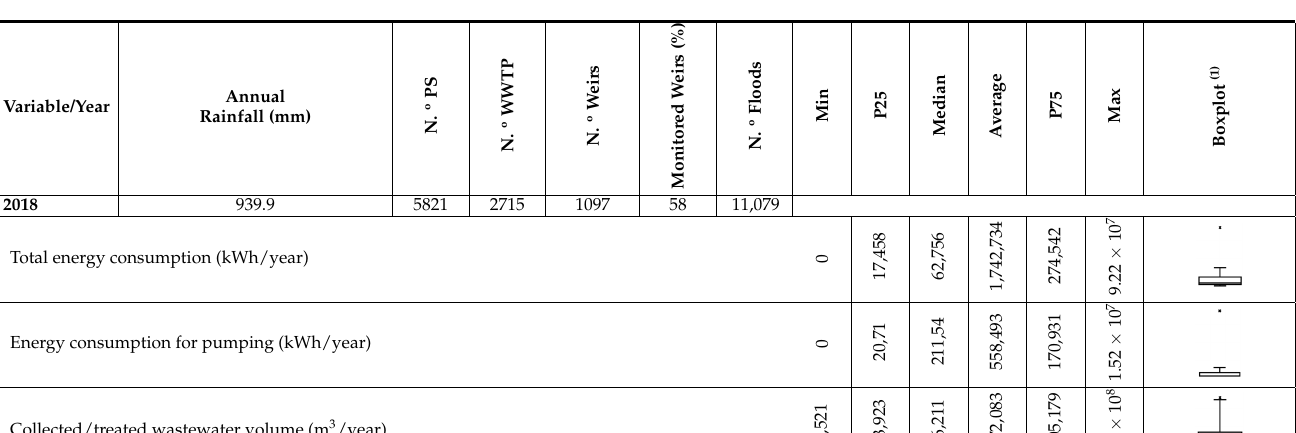
Table A5. National characterization for the evaluation of the W ‐ E ‐ G nexus for 2018.